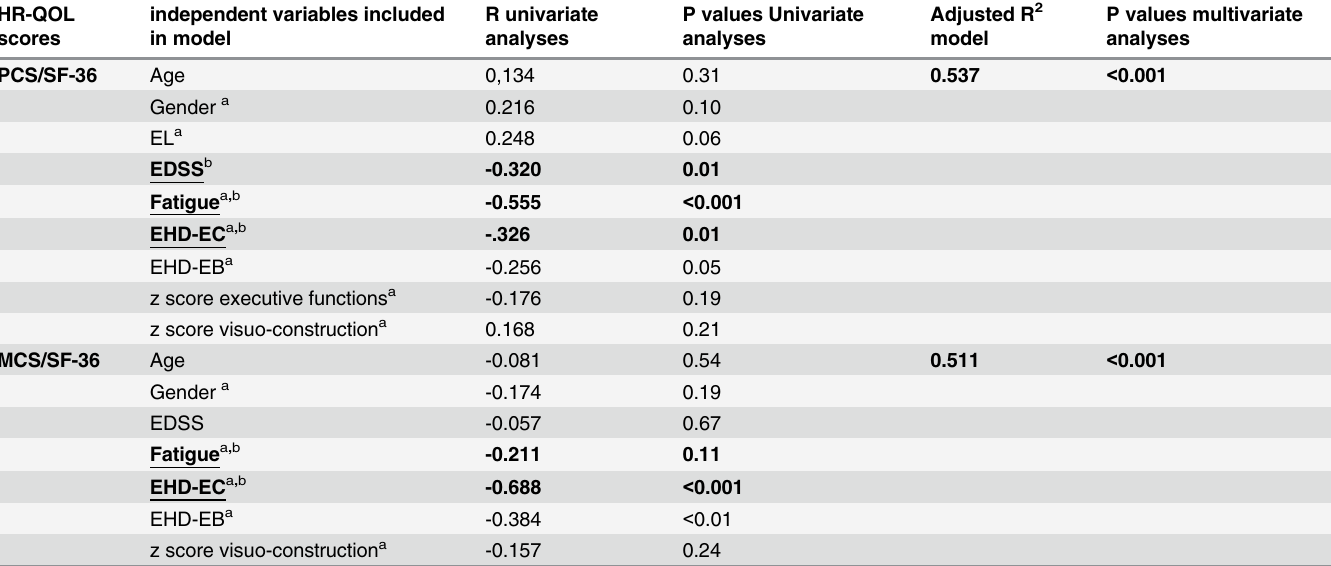
Table 4. Multivariate analyses of HR-QOL in RRMS patients (models including EHD PRO-subscales). HR-QOL independent variables included scores in